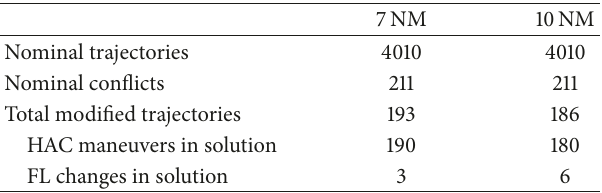
Table 2: Main results obtained during the CR process with separa- tions of 7 NM and